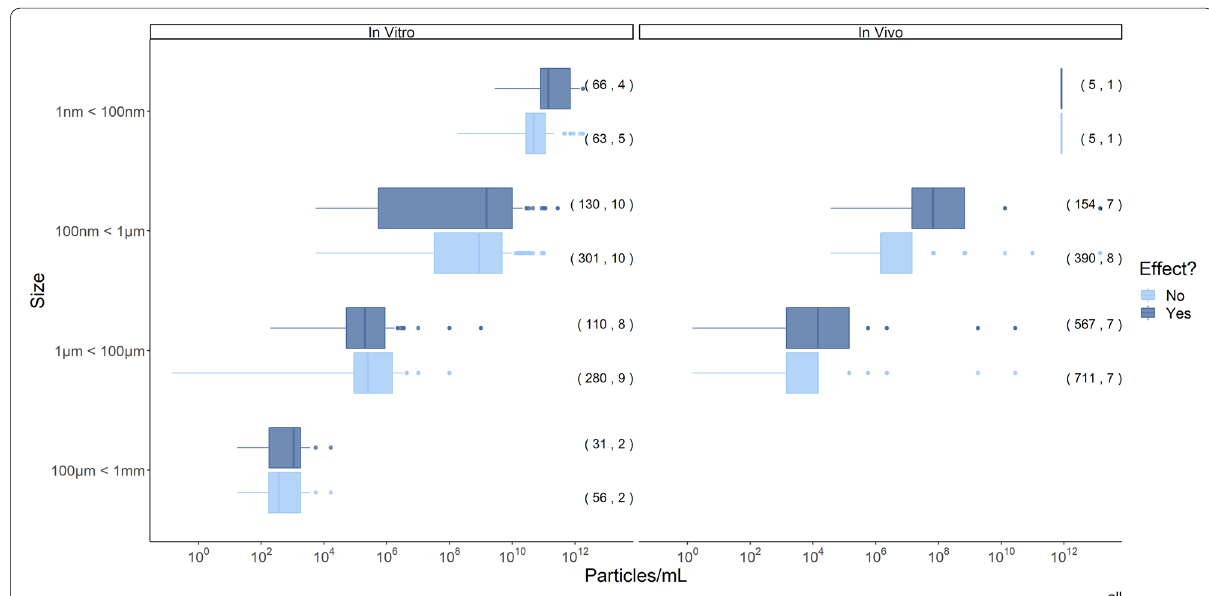
Fig. 2 Representative graphic generated using the Exploration tab in the Human Health database. Labels on the right side indicate the number of studies and measured endpoints available in the database. Endpoints where effects were detected are indicated by “Yes” (dark blue bars) whereas endpoints where effects were not detected are indicated by “No” (light blue bars). Data are divided into in vitro and in vivo data as indicated by the labels above. Doses for each endpoint are displayed on the x axis in particles per volume, but other dose metrics such as mass and volume are also